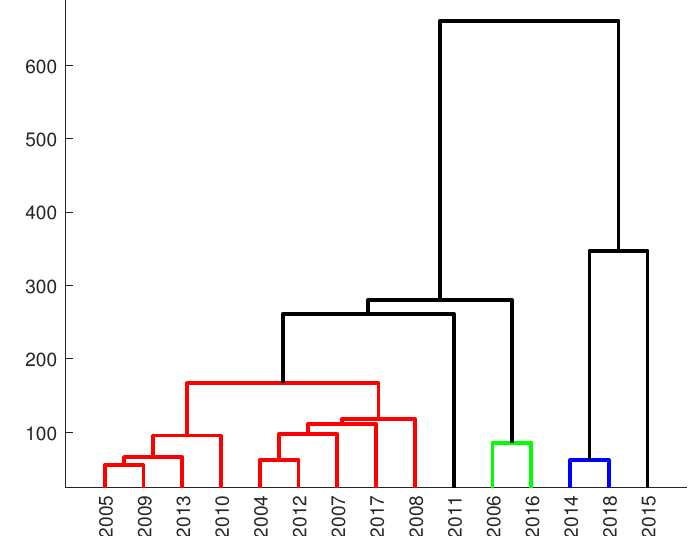
Figure 13. Dendrogram for time series of detrended groundwater level corresponding to winter seasons from applying the AHP clustering.